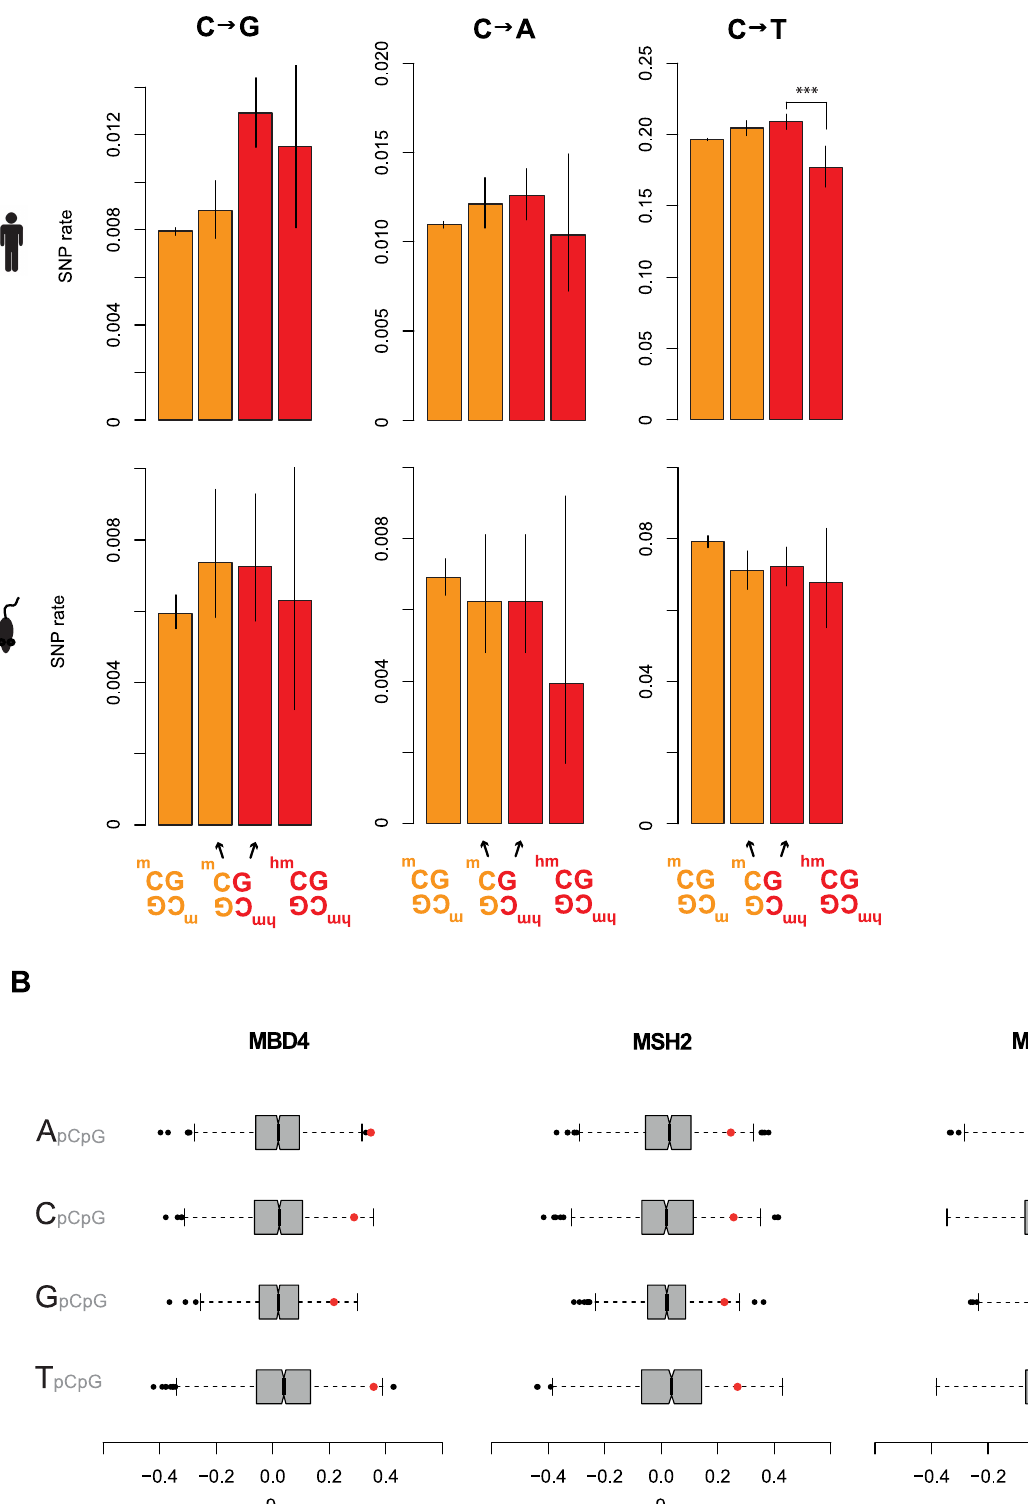
Figure 5. Elevated C to G rates at asymmetrically hydroxymethylated sites. (A) Rates of cytosine loss in the human and mouse population as a function of methylation status and symmetry. Only significant differences between rates at symmetrically and asymmetrically hydroxymethylated 5hmC sites are shown (***P , 0.001). Error bars are 95% confidence intervals, calculated using Wilson’s interval score for single proportions. Rates for